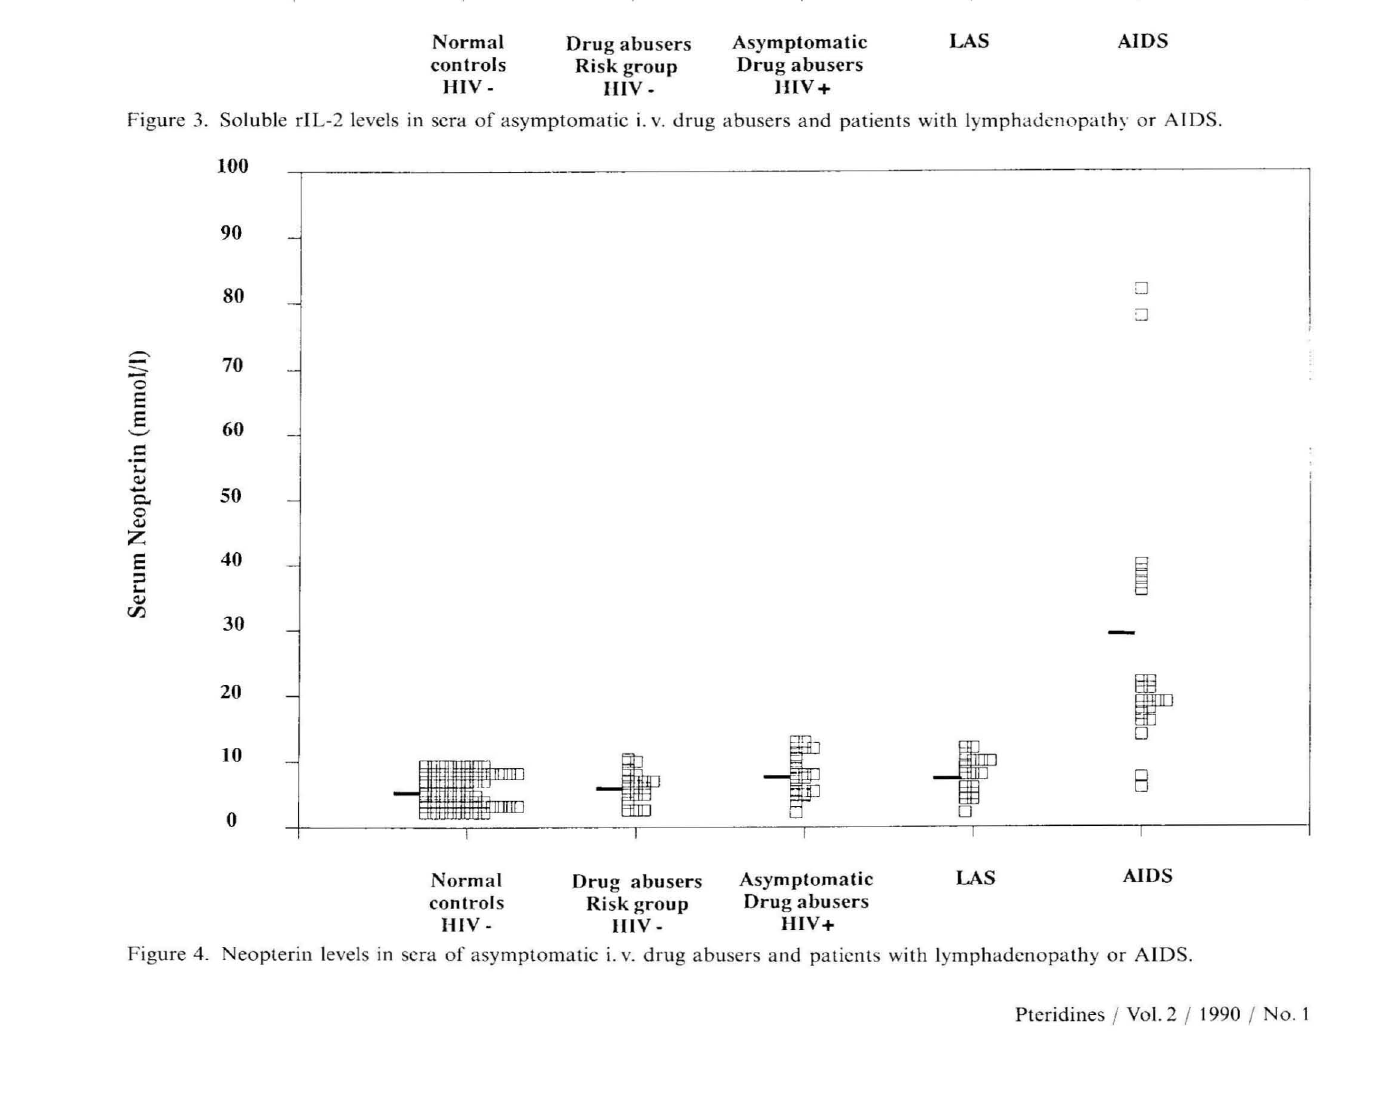
Figure 4. Neopterin levels in sera of asymptomatic i. v. drug abusers and patients with lymphadenopathy or